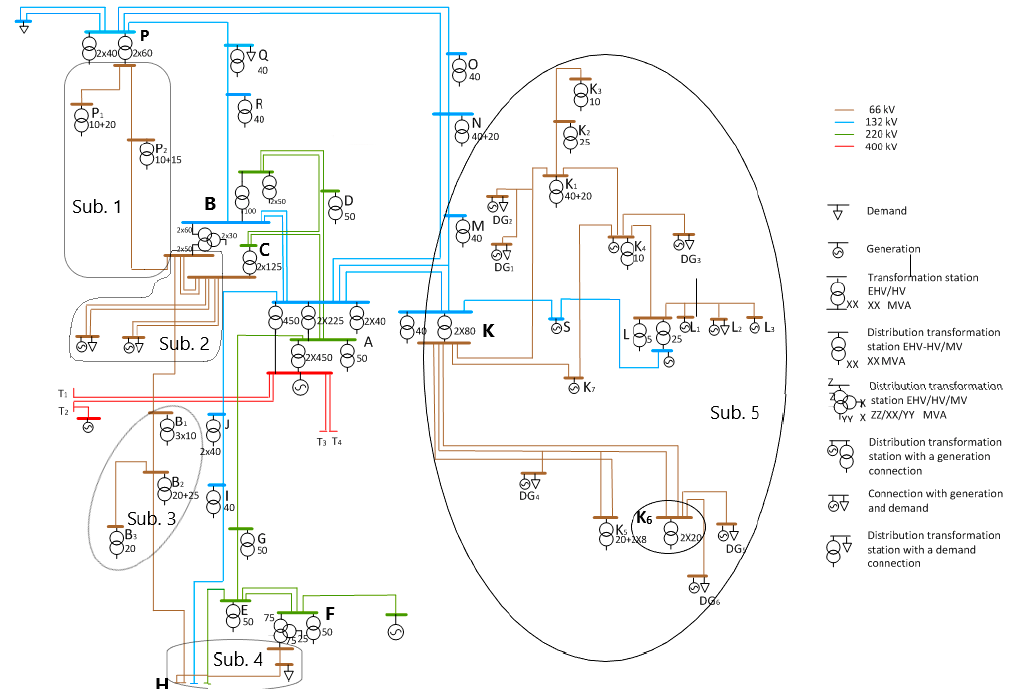
Figure 4. 400 kV and 220 kV (EHV) and 132 kV and 66 kV (HV) electric schematic of the network where subsystem K and K6 used to test the proposed methodology are located.